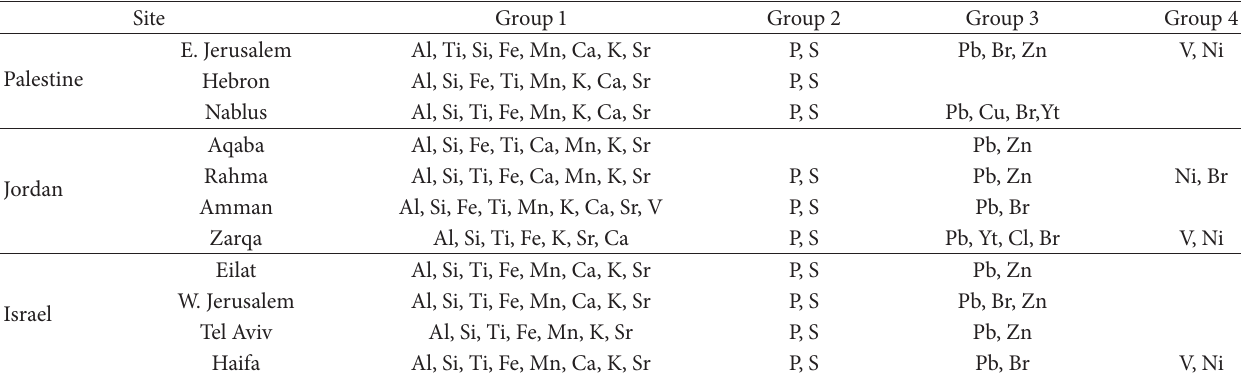
Table 2: Cluster analysis results for metals observed at each